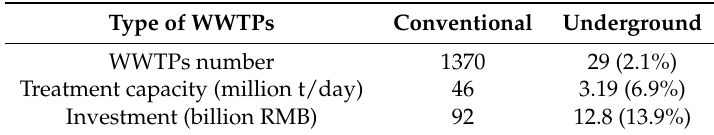
Table 1. Comparison of new built conventional and underground WWTPs during 12th Five-Year Plan (2011–2015) in